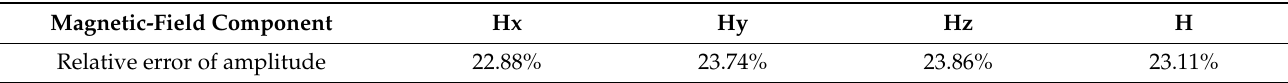
Table 1. Relative error of the magnetic field is obtained when 2193 data is used. Magnetic-Field Component Hx Hy Hz H Relative error of amplitude Relative error of